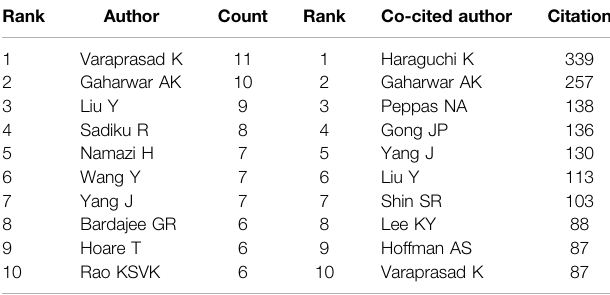
Frontiers in Bioengineering and Biotechnology |